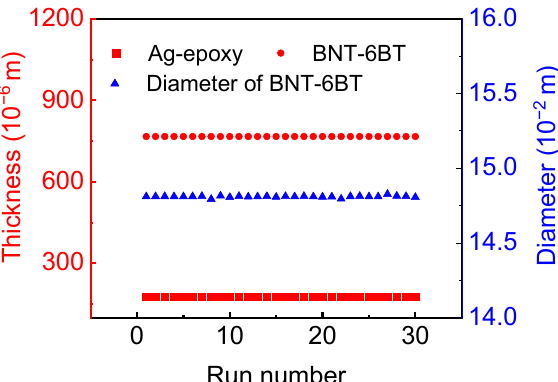
Figure 5. Optimized design parameters of the ultrasonic transducer.